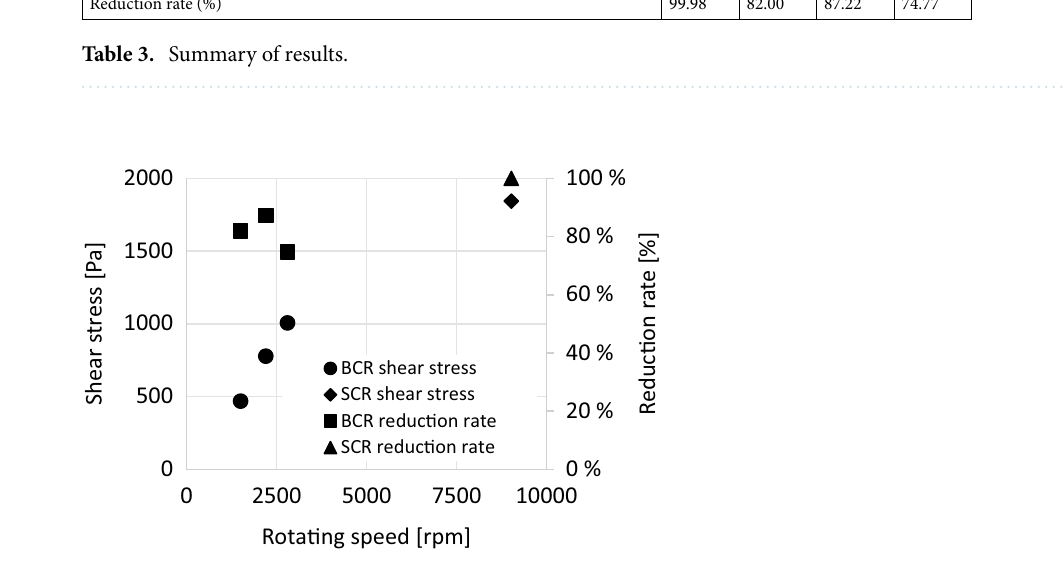
Figure 7. Shear stress and reduction rate values at different